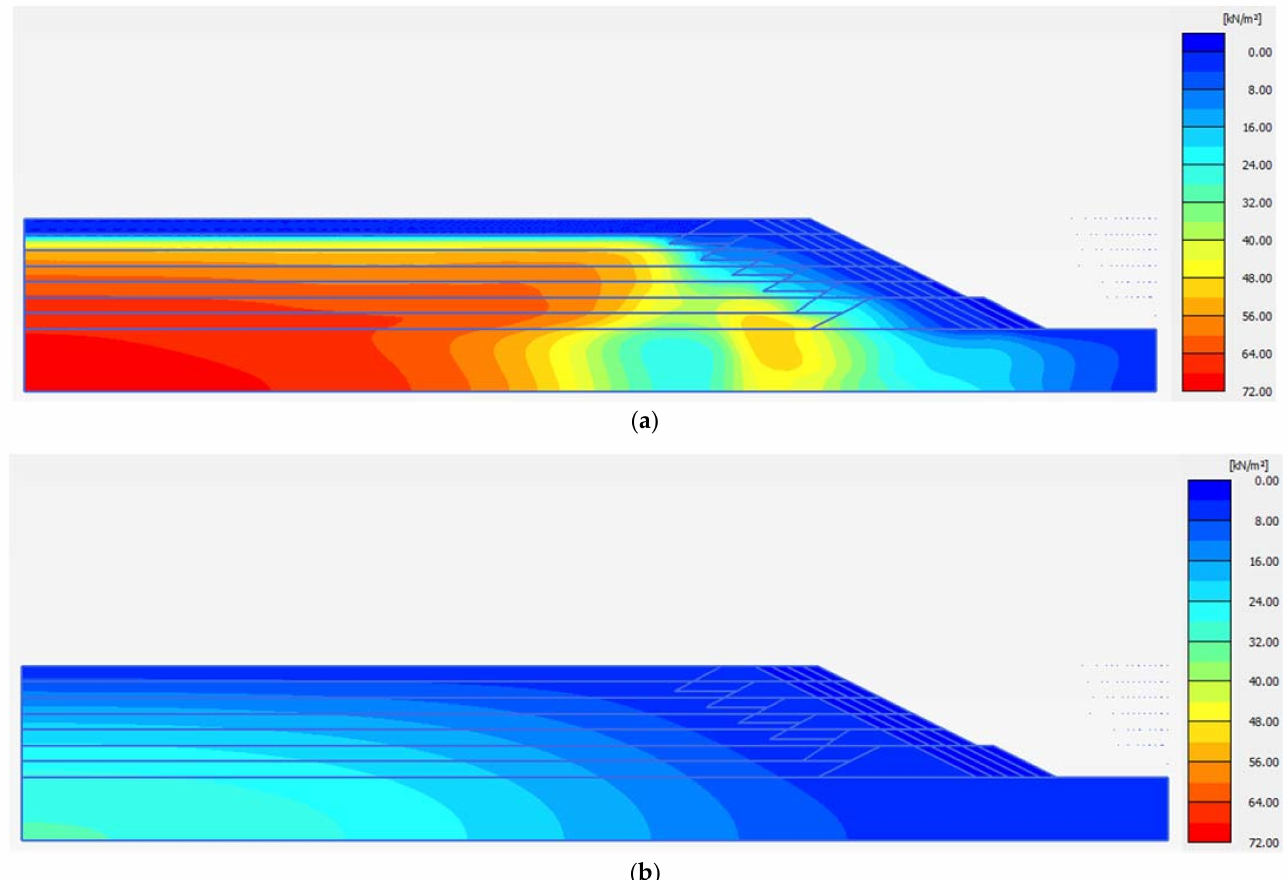
Figure 7. Excess pore water pressure at the last construction stage with the pond filling rate of 2.5 m/year and rockfill width of 20 m: ( a ) after the raising phase R5 and ( b ) after the consolidation phase C5.